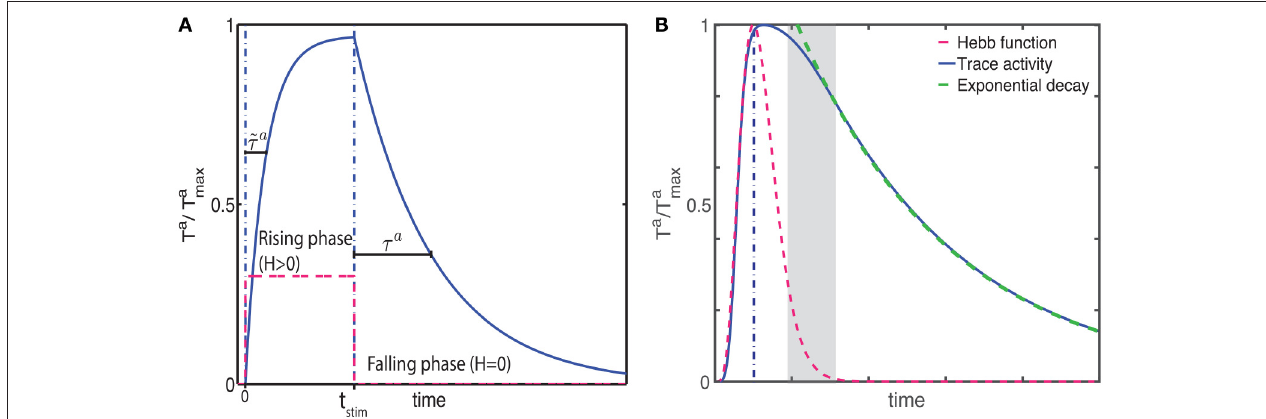
FIGURE 1 | Examples of trace activity for different time-dependent Hebbian functions. (A) Temporal profile of synaptic eligibility traces for a square Hebbian stimulus, illustrated by the dashed red line, with onset at time t = 0 and offset at time t = t stim . Traces rise with a time constant ˜ τ a (Equation 5) to an upper steady state ˜ T a (Equation 4) and decay to zero with a slower time constant τ a . (B) A smooth, time-varying Hebbian function (dashed red line) representing the contributions of pre- and post-synaptic cell activity and the resulting synaptic eligibility trace obtained from Equation (7) (blue). After the Hebbian term has decayed to zero, the dynamic of the trace follows an exponential decay